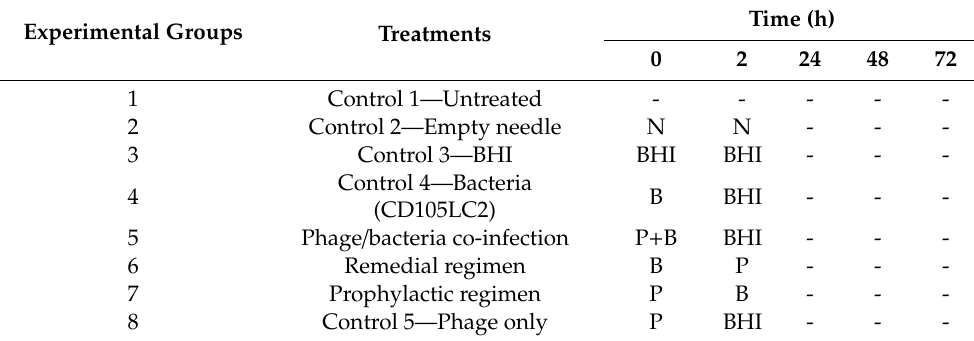
Table 1. Treatment regimens for the controls, prophylactic and remedial phage therapy used in this